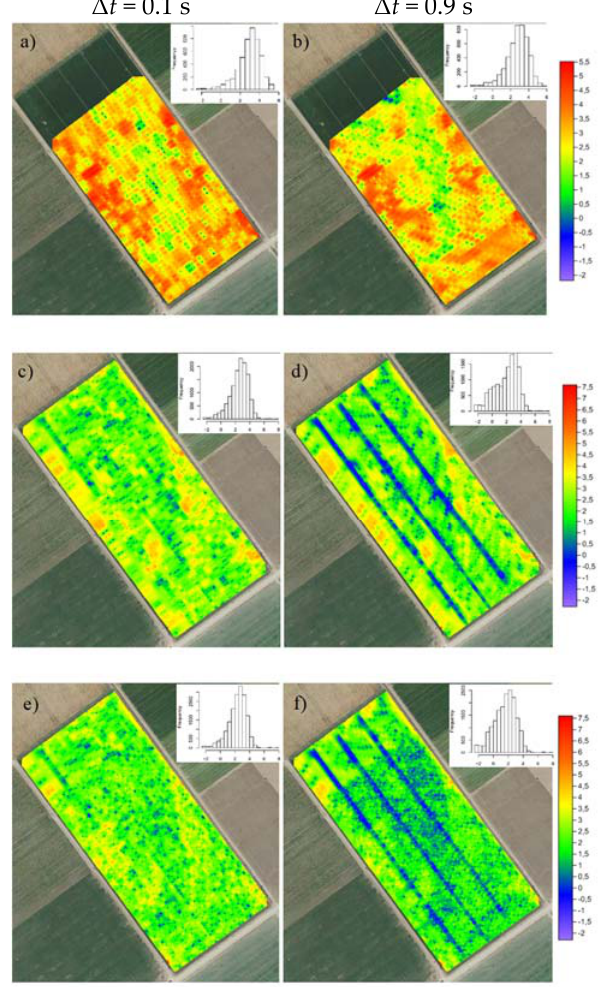
Figure 4. Maps and histograms of ln-transformed absolute nearest neighbor difference distribution (ln| ∆ z |) of H1 ECa. ( a , c , e ), non-optimized ( ∆ t = 0.1 s) and ( b , d , f ) optimized ( ∆ t = 0.9 s) time lags ( ∆ t ) for data set combinations C ( a , b ), A + B ( c , d ), and A + B + C ( e , f ).